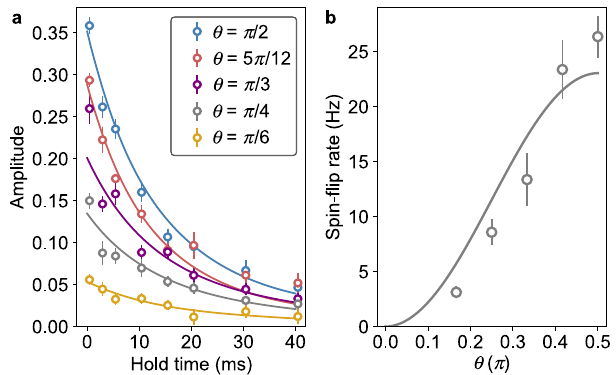
Fig. 3 Spin-rotation-angle dependence of transport dynamics. a Time evolution of the oscillation amplitude for different spin-rotation angles: θ = π /2, 5 π /12, π /3, π /4, and π /6. Error bars are 1 σ con fi dence intervals of the oscillation amplitude. Solid lines represent fi ts to the data with Eq. (9). b Spin- fl ip rate as a function of the rotation angle θ . Error bars are 1 σ con fi dence intervals of the spin- fl ip rate. A solid line represents a fi t to the data with a sine-squared